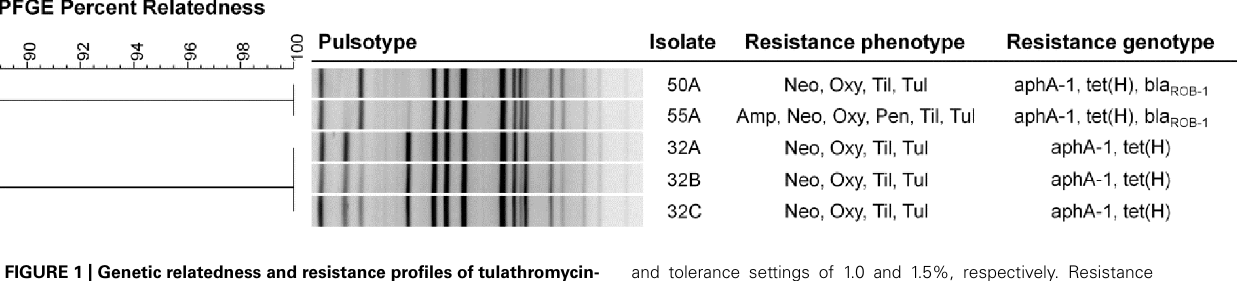
FIGURE 1 | Genetic relatedness and resistance profiles of tulathromycin- resistant Mannheimia haemolytica collected from feedlot cattle. The dendrogram was created using UPGMA clustering of Dice coefficient values. Similarity matrix was based on band-matching analysis, optimization